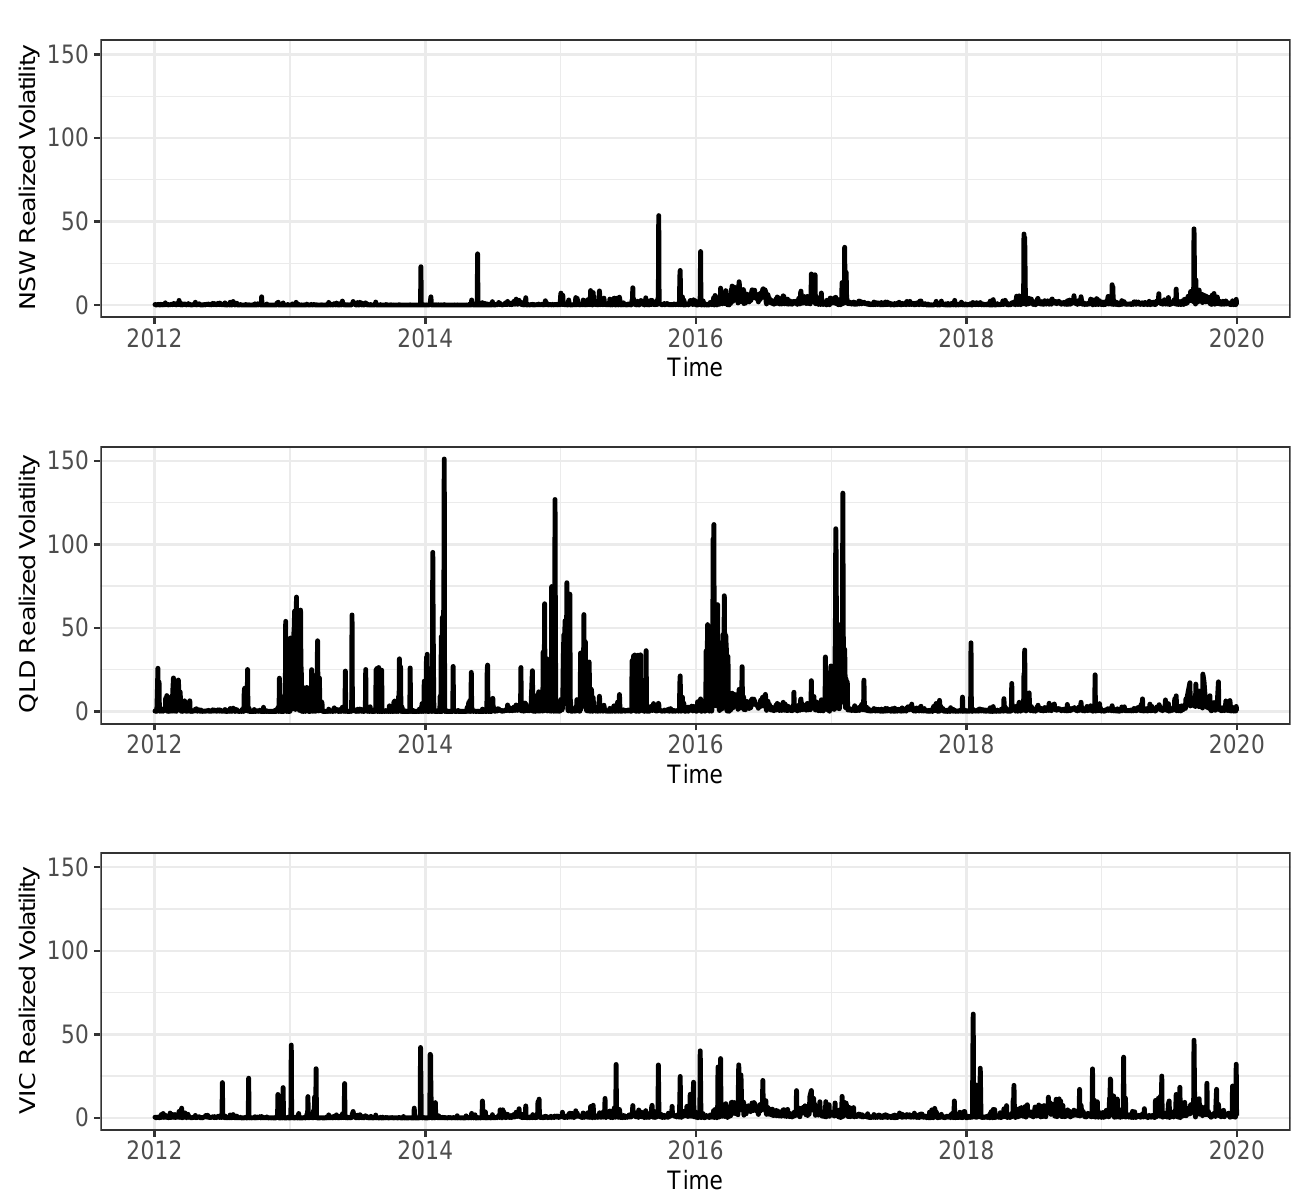
Figure 2. 30-min Realized Volatility. Time series of 30-min Realized Volatility for NSW ( top ), QLD ( middle ), and VIC ( bottom ). The sample period is from 1 January 2012 to 31 December